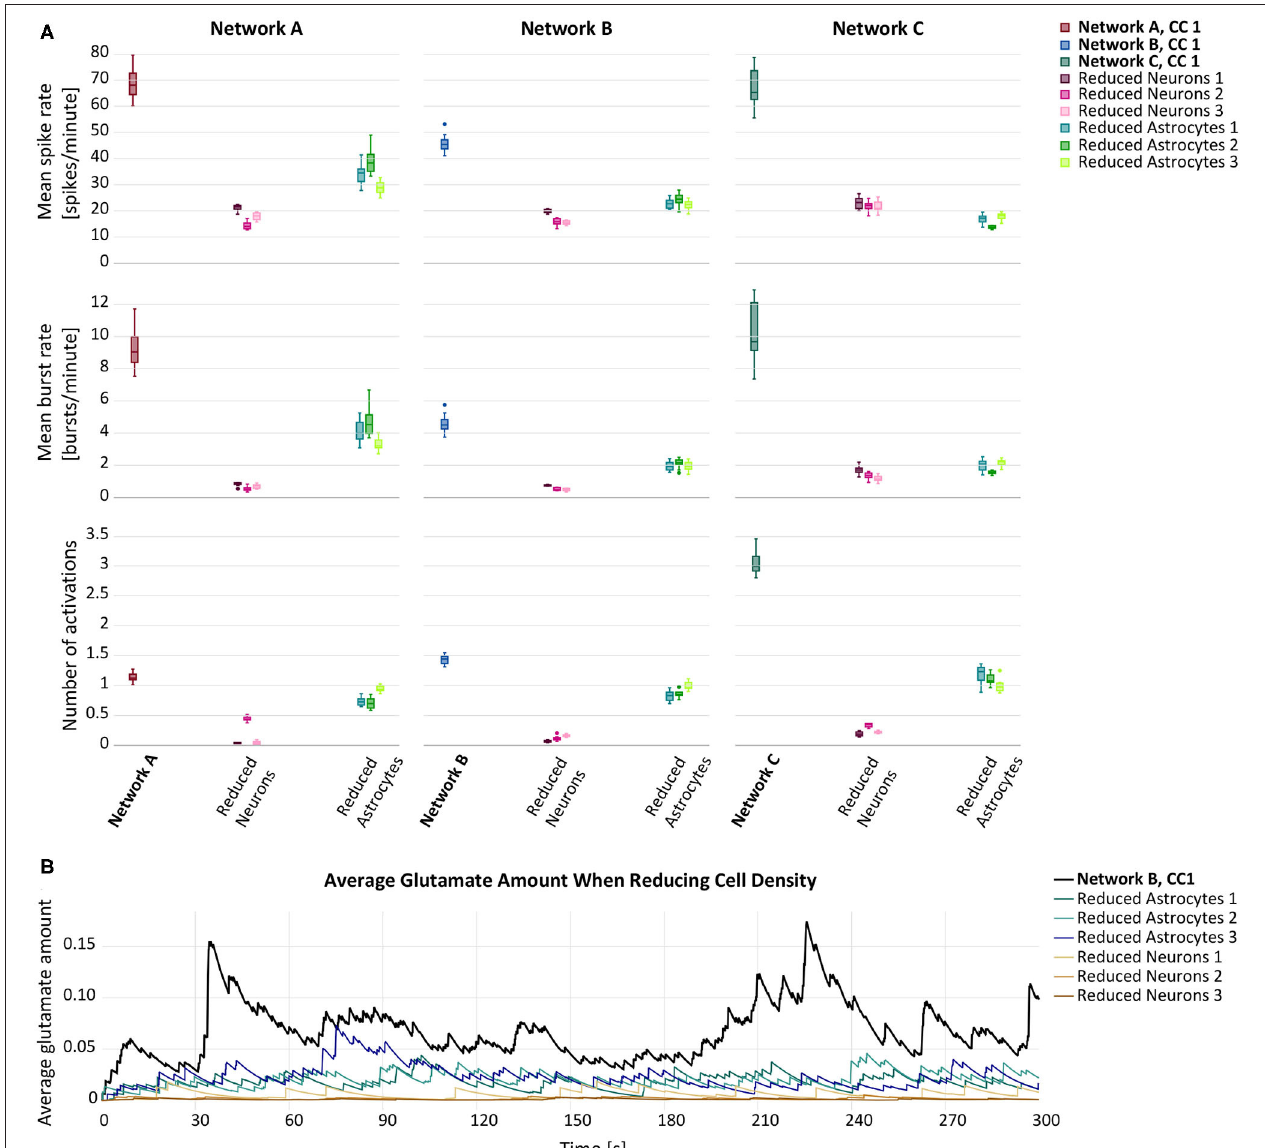
FIGURE 2 | (A) Mean spike rate (top), mean burst rate (middle) and mean number of activations per astrocyte (bottom) resulting from the networks with reduced astrocyte or neuron density compared to the default networks A–C with connectivity configuration CC 1 (bold). (B) Average glutamate amount in astrocytes when randomly removing 25% of either astrocytes (blue lines) or neurons (brown lines) from a premade network configuration B, CC 1 (black line).